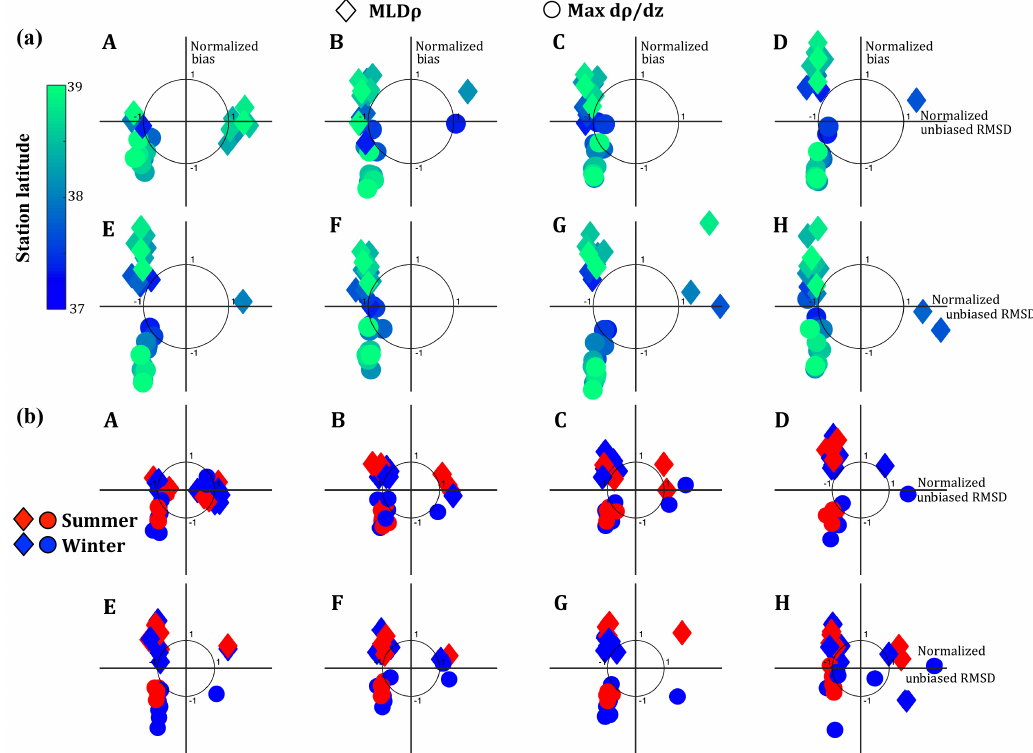
Figure 7. Normalized target diagrams for Models A–H demonstrating the (a) temporal and (b) spatial skill in resolving the variability of the strength of density stratification (circles) and the depth of pycnocline initiation (diamonds). In (a) the individual dots represent the 13 stations along the main stem of the Chesapeake Bay. In (b) the dots represent the 24 months of 2004–2005 and are delineated by color: red is summer (May–September) and blue is winter (October–April).